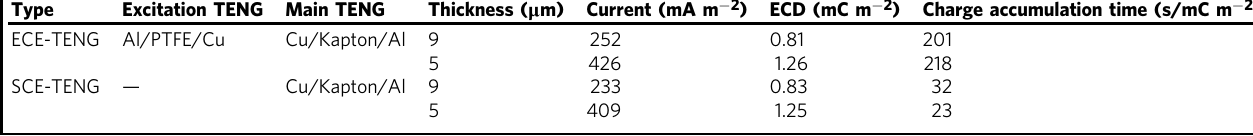
Table 1 The parameters and output properties of charge excitation TENG